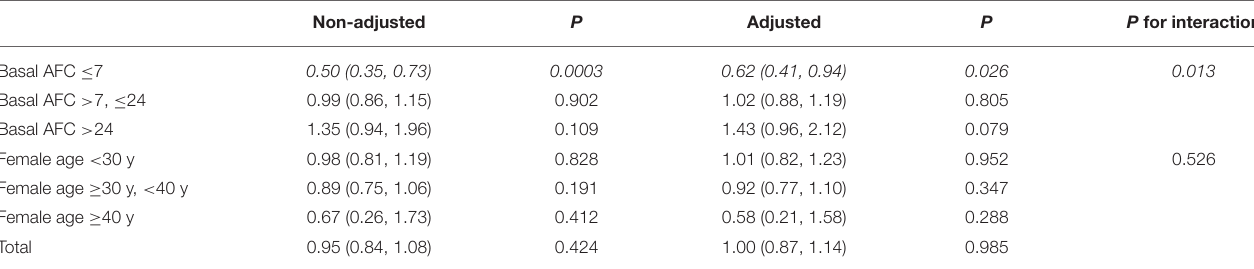
TABLE 2 | Comparison of cLBRs of flexible GnRH antagonist protocol vs. GnRH agonist long protocol using multivariable regression analysis in subgroup patients with different AFCs and of different